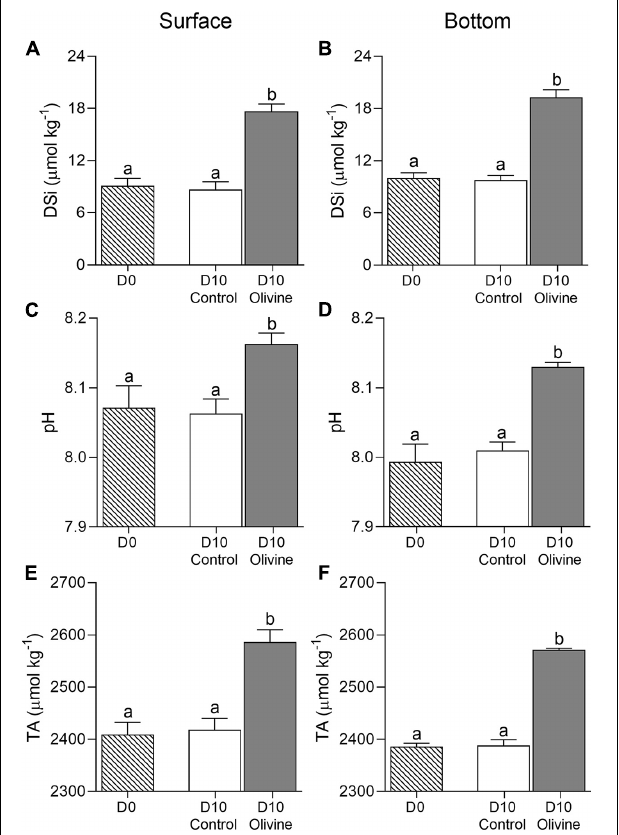
FIGURE 3 | Changes of Shannon–Weiner index of the particle-attached (A,B) PA, 3–20 µ m and free-living (C,D) FL, 0.2–3 µ m bacterial communities in initial and 10-day incubated seawater with or without olivine addition, from the surface (A,C) and bottom layers (B,D) of the sampling site. The vertical bar indicates the standard deviation ( N = 3), and different letters indicate significant differences ( p <